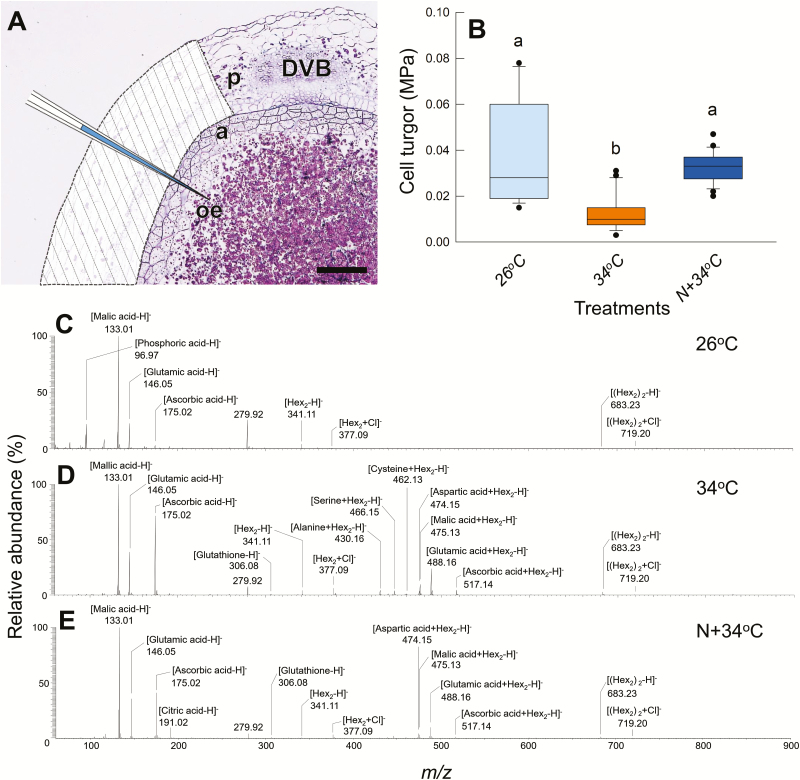
Cell turgor and metabolite profiling in the putative chalky zone of rice kernels. (A) Image of a transverse section of the dorsal side of a kernel at the early ripening stage (12 d after heading, DAH) including a diagram of the pressure probe used for extraction of sap from the outer endosperm cells. A part of the pericarp, indicated by the shaded area, was removed prior to the insertion of the probe tip (see Methods). DVB, dorsal vascular bundle; a, aleurone layer; oe, outer endosperm; p, pericarp. The scale bar is 100 µm. (B) Box-plot showing the cell turgor in the outer endosperm in each heat/nitrogen treatment assayed at 12 DAH. Data are from 14–29 cells from 7–8 kernels from at least three different plants in each treatment and show the mean, the upper and lower quartiles, the maximum and minimum values, and outliers (dots). Different letters indicate significant differences as determined using a Tukey–Kramer test: P<0.05. (C–E) Mass spectra for picoPPESI-MS in negative ion mode obtained from the outer-endosperm cells for the different treatments at 12 DAH. The data are representative of repeated experiments with 4–5 kernels in each treatment.